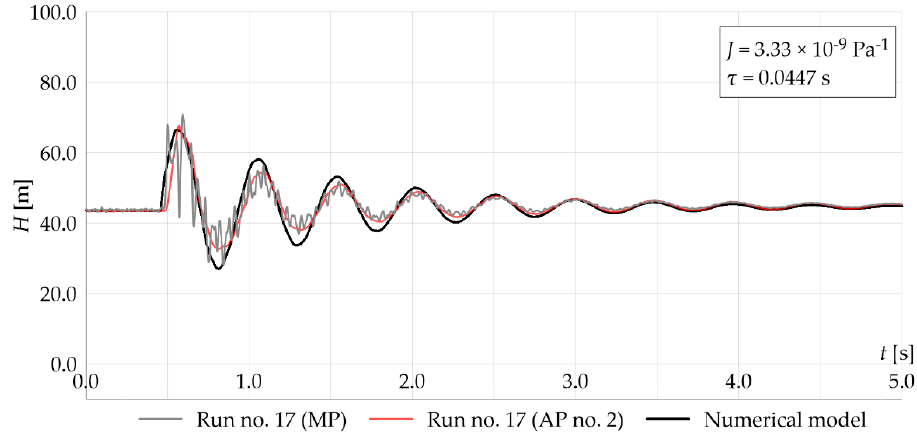
Figure 14. Comparison between calculated and observed pressure oscillations.